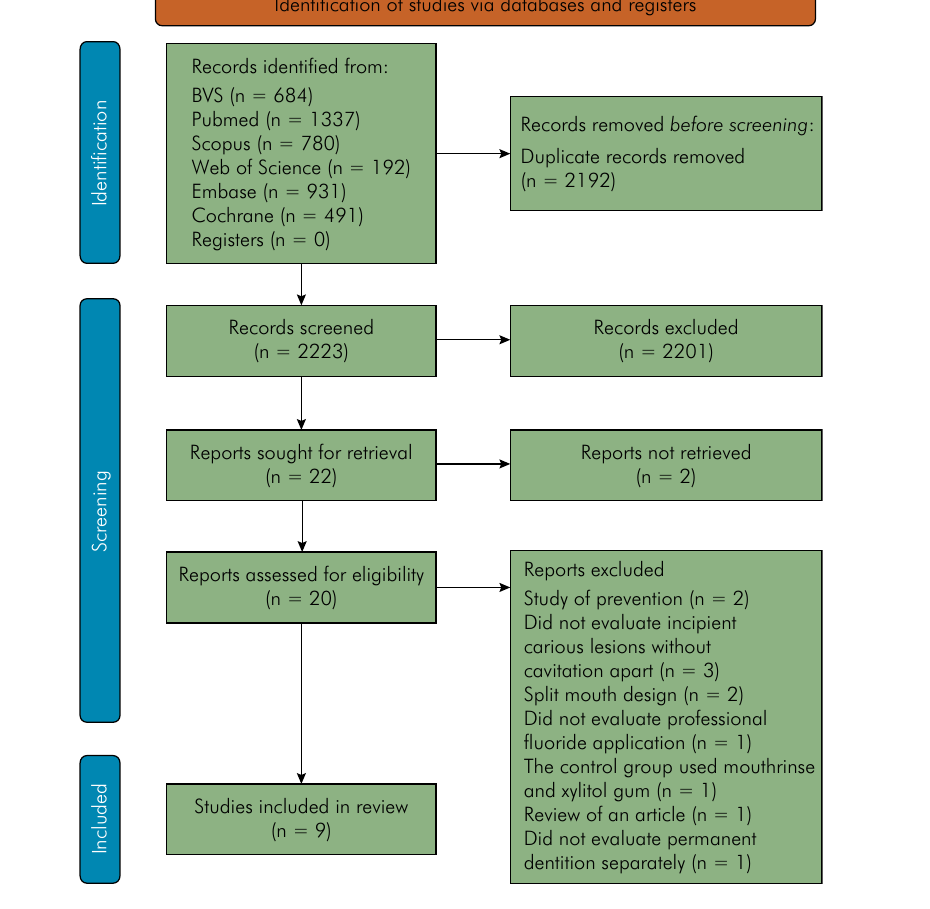
Figure 1. Flowchart showing the inclusion of studies according to the PRISMA